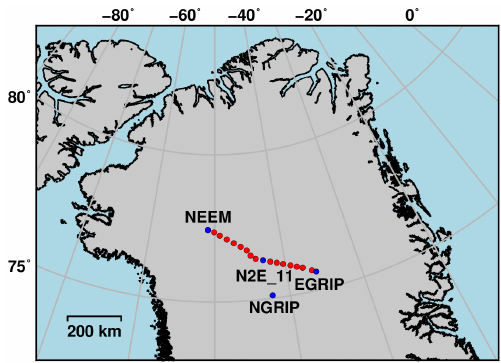
Figure 1. The N2E traverse route with the measurement sites ac- cording to Table